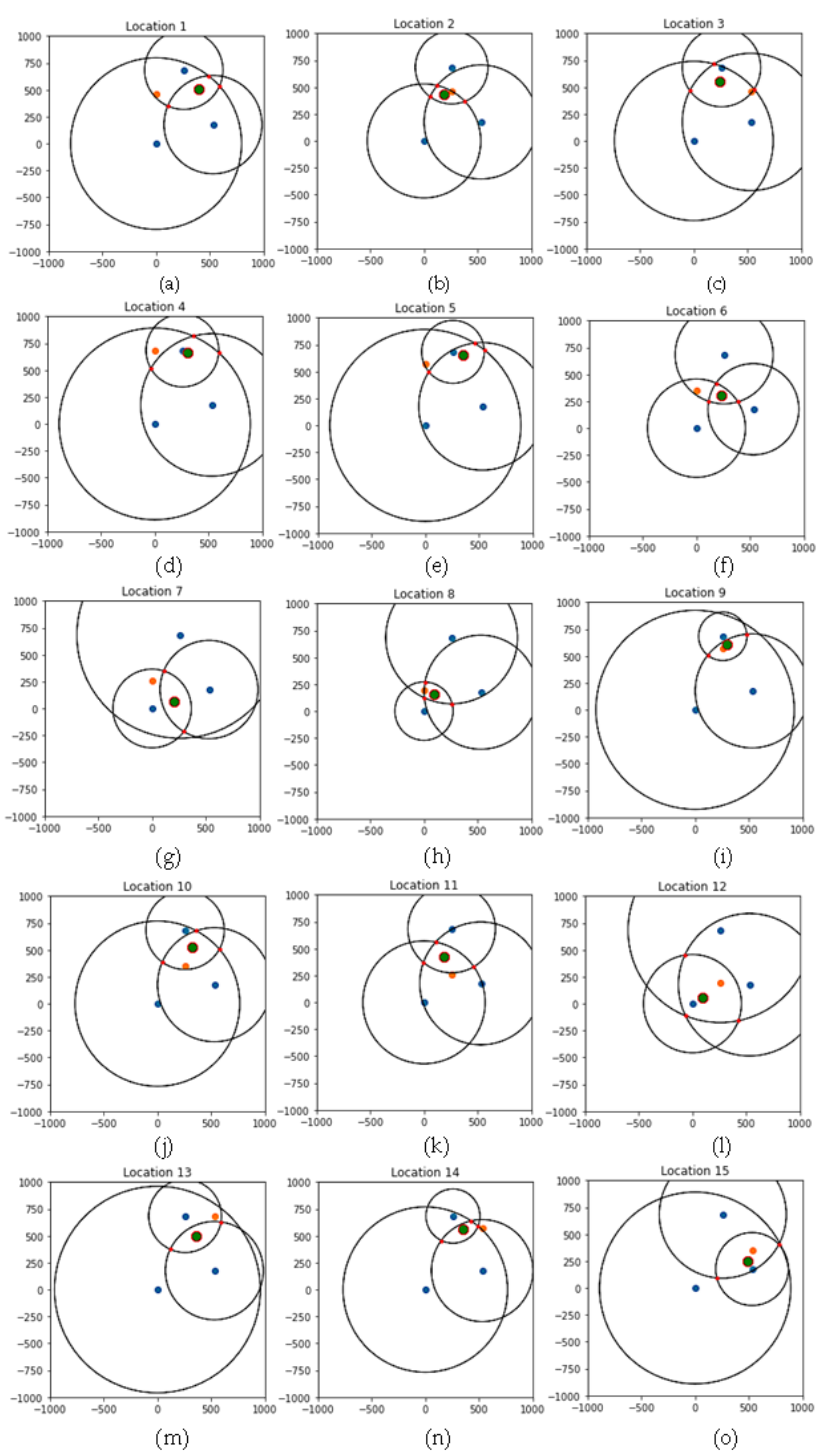
Figure 4. Estimated locations for each fixed location. ( a ) Estimated location for location 1; ( b ) Esti- mated location for location 2; ( c ) Estimated location for location 3; ( d ) Estimated location for location 4; ( e ) Estimated location for location 5; ( f ) Estimated location for location 6; ( g ) Estimated location for location 7; ( h ) Estimated location for location 8; ( i ) Estimated location for location 9; ( j ) Estimated location for location 10; ( k ) Estimated location for location 11; ( l ) Estimated location for location 12; ( m ) Estimated location for location 13; ( n ) Estimated location for location 14; ( o ) Estimated location for location